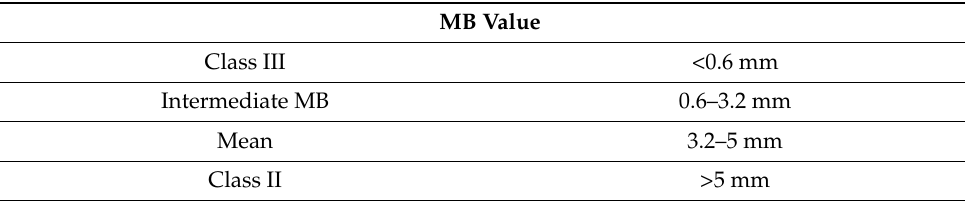
Table 8. Identification of intervals regarding the spatial evaluation of the mandible with respect to the plane coursing the Anterior Nasal Spine (ANS). This spatial value is defined as Mandible (MB).